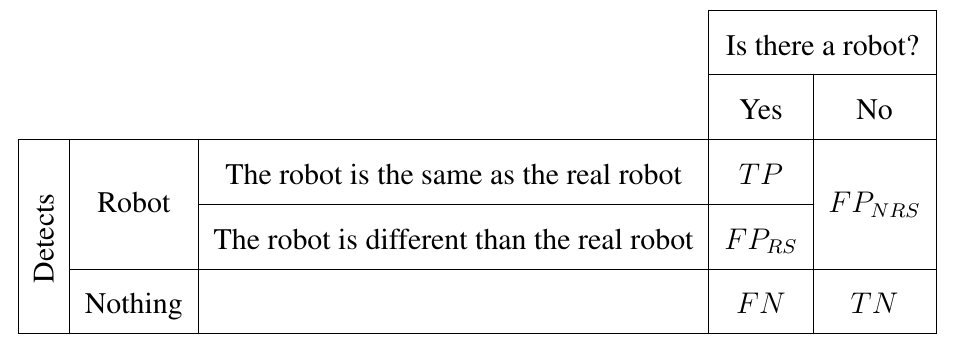
Table 1. Confusion matrix used to classify the robot detection and tracking algorithm